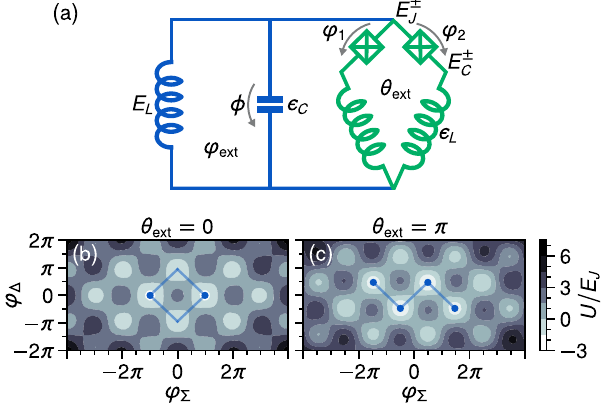
FIG. 2. Schematic of the experimental device. (a) Electrical circuit diagram for the KITE (green) shunted by a superinduc- tance and a capacitance (blue). Additionally, the two small Josephson junctions are allowed to have slightly differing areas, so E (cid:2) ¼ ð 1 (cid:2) ϵ Þ E J and E (cid:2) ¼ E C = ð 1 (cid:2) ϵ Þ , with ϵ being a small J C asymmetry parameter. (b),(c) Potential energy landscape at the π and θ 0 ; π . Here, φ external flux bias points φ Σ and ext ¼ ext ¼ φ Δ are the symmetric and antisymmetric combinations, respec- tively, of the phase drops across the two junctions of the KITE. The low-energy physics is dominated by tunneling (semitrans- parent blue segments) between the lowest potential wells (solid blue